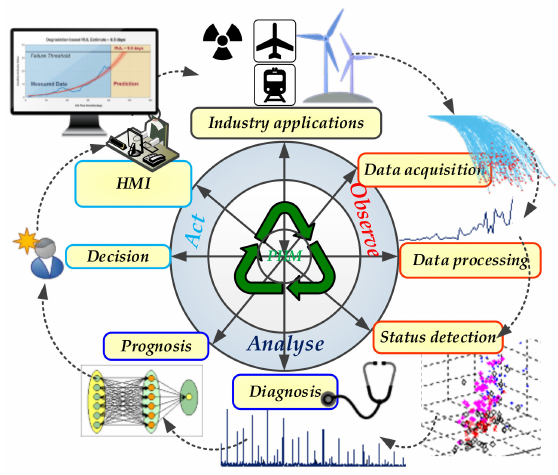
Figure 5. PHM cycle. Reproduced from [15], Elsevier, and from [16], IEEE.